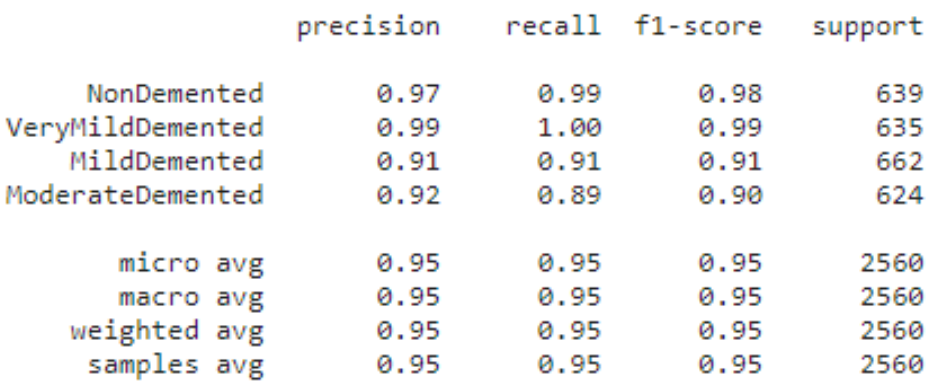
Figure 18. Classification Report of Tested Data.